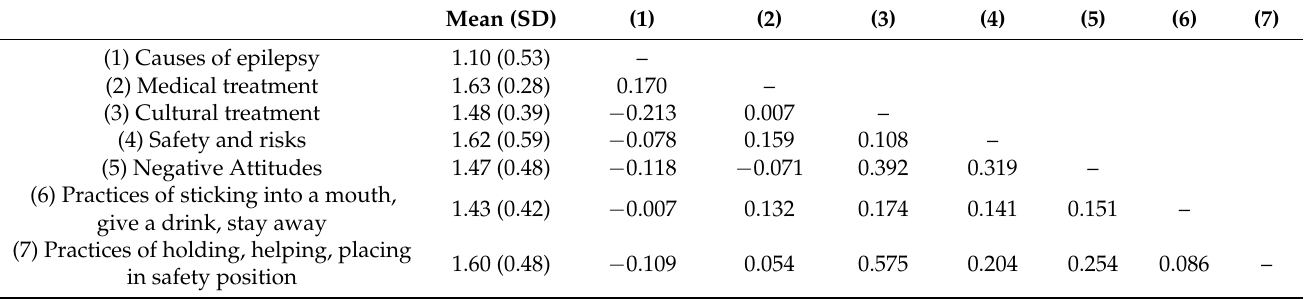
Table 4. Average of subscales and Pearson correlation (r) between subscales of the questionnaire of knowledges, attitudes, and practices towards epilepsy in Sofala,